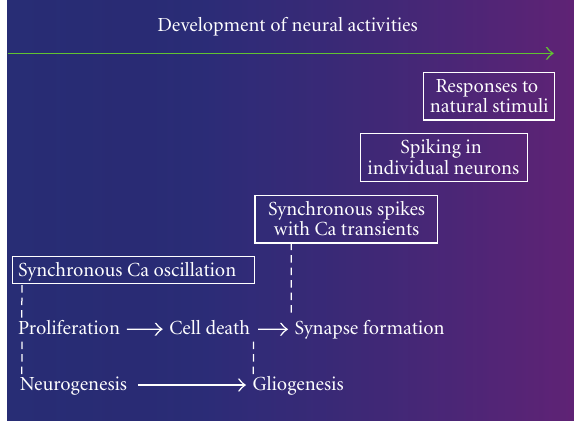
Figure 2: Developmental changes in neural activities. Self-renewing neuroepithelial cells show spontaneous, synchronous calcium oscillations. Newborn neurons show synchronous burst spike discharges before synapse formation. This figure is cited from [6].